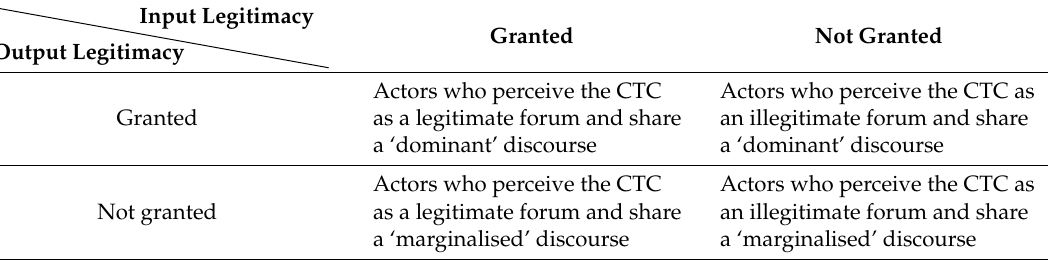
Table 3. Rules to evaluate the overall legitimacy of REDD+ governance in Mexico. Source: own